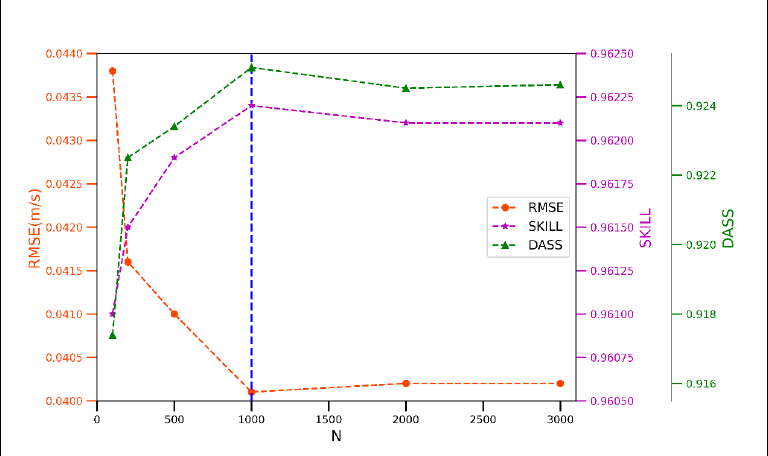
Figure 9. RMSE, SKILL, and DASS of PF versus the number of particles, N.